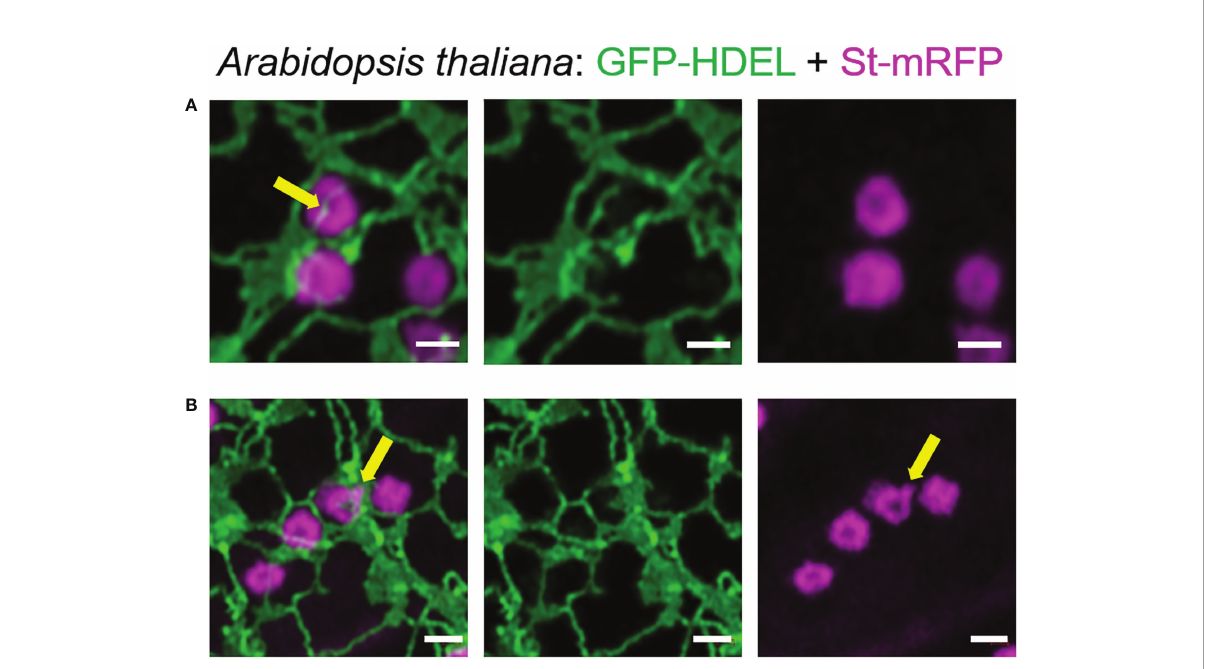
FIGURE 5 The organization of the ER and Golgi shown in tobacco can also be observed in Arabidopsis transgenic plants. ER tubules wrapped around and through the Golgi body ( A , yellow arrow) and dynamic protrusions from the Golgi body ( B , yellow arrow) were also observed in stably transformed Arabidopsis thaliana plants. Golgi bodies were labelled with the medial/ trans -Golgi marker ST-mRFP (in magenta) and the ER is labelled with GFP-HDEL in green. Size bars = 1